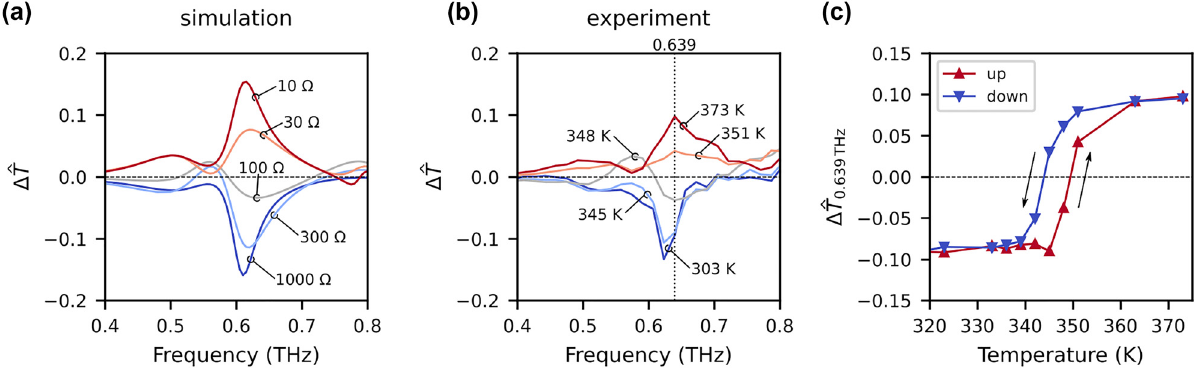
. (b) Measured Δ ̂ T spectra of the metasurface for a set s